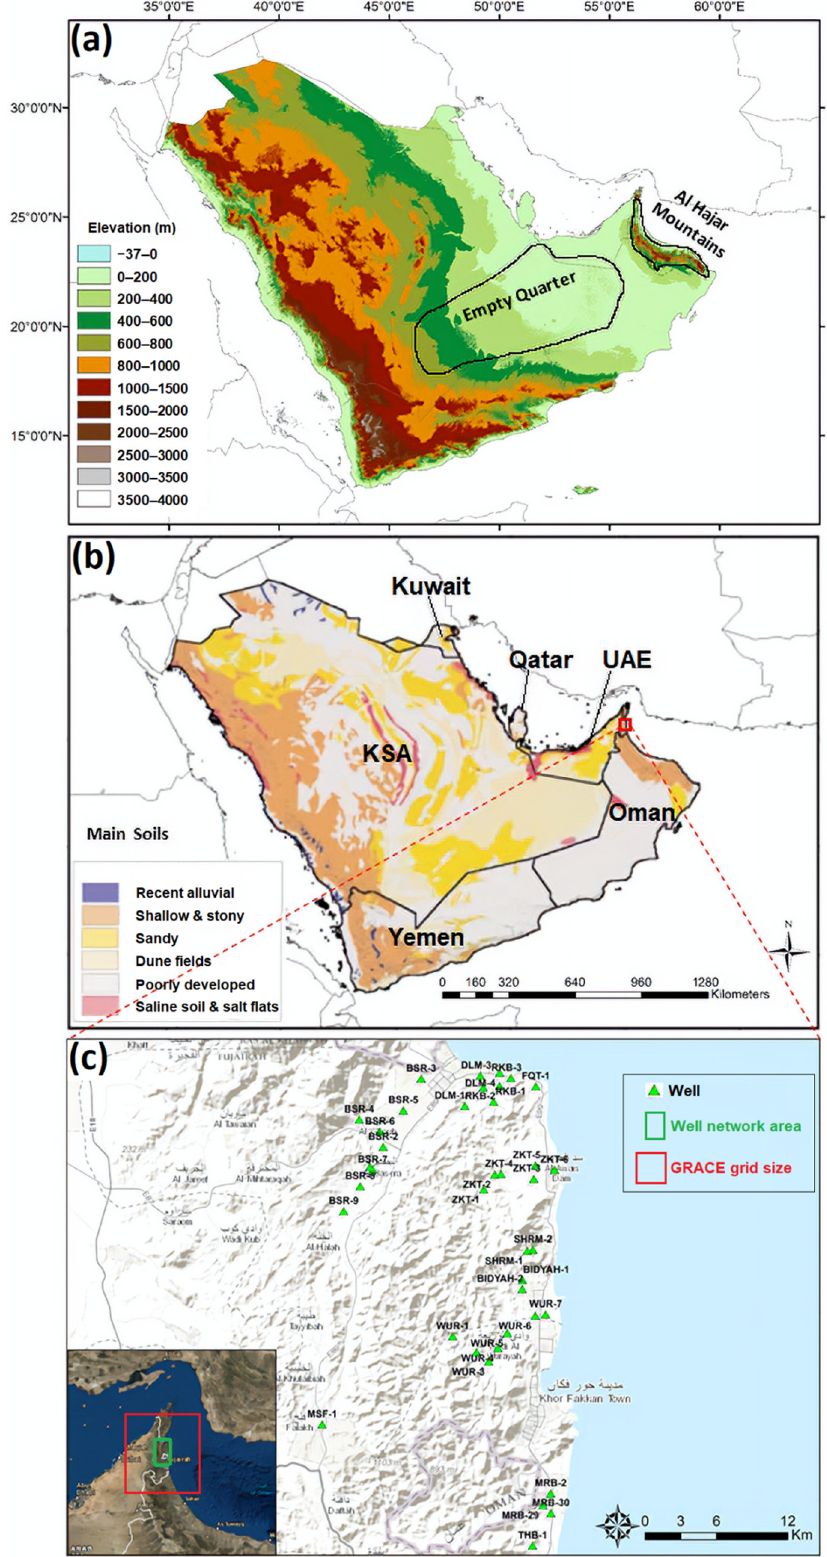
Figure 1. Terrain elevations ( a ) and soil types ( b ) from the GTOPO30 Digital Elevation Model [28] and De Pauw [29], respectively. The spatial distribution of the observational well network in the United Arab Emirates (UAE) is shown in subplot ( c ).